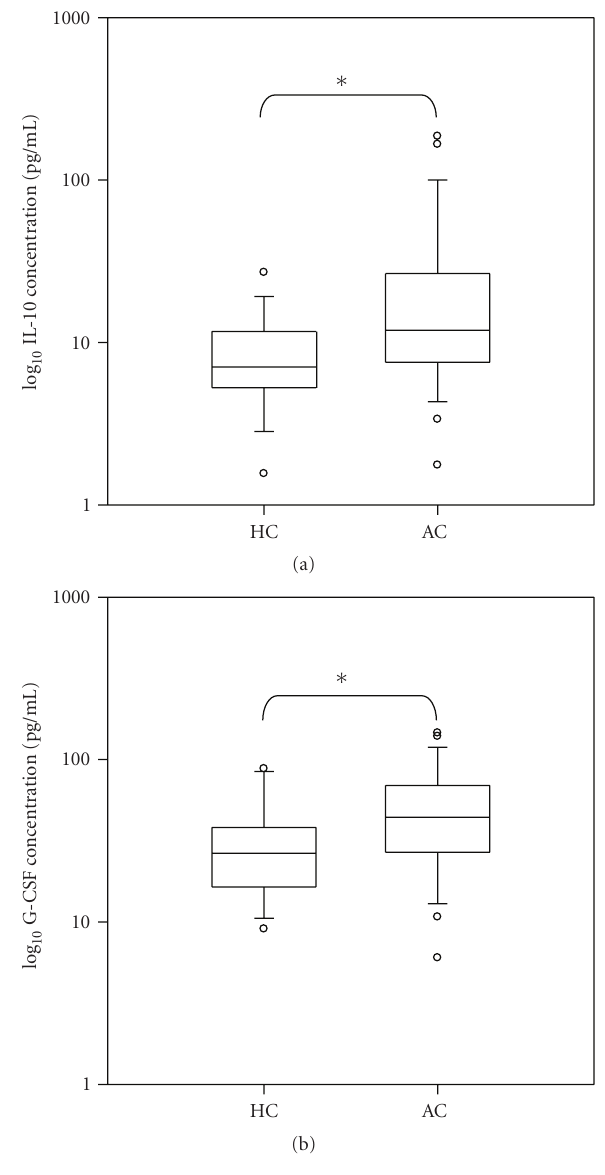
Figure 1: Concentration of plasma IL-10 and G-CSF in pregnant women with asymptomatic malaria ( n = 25) and healthy controls ( n = 15). Box plots represent median log concentration (pg/ml) and 25th and 75th percentiles. Outliers are shown as points outside the 10th and 90th percentile bars. HC represents healthy controls. AC denotes asymptomatic carriers. ∗ P < . 05 is statistically